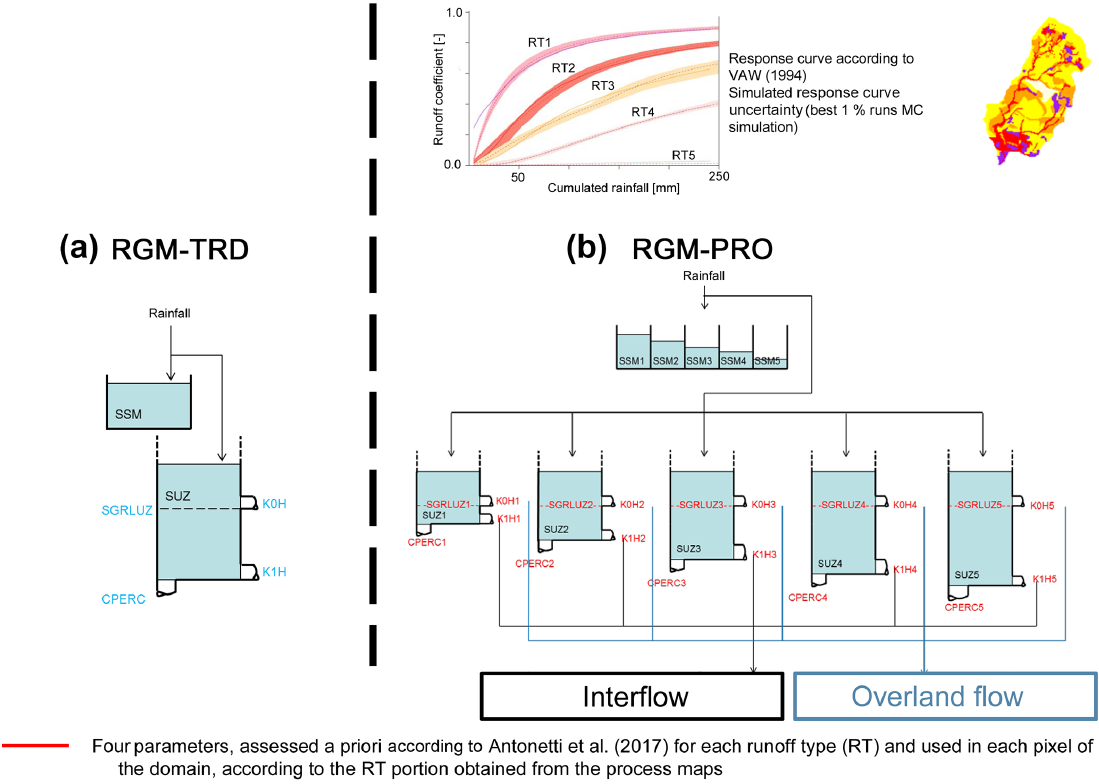
Figure 2. Structure of the adopted RGMs. (a) RGM-TRD module from the traditional PREVAH model, with four parameters requiring calibration (Gurtz et al., 2003) and validity for the whole target area. b RGM-PRO module using typical infiltration curves for a priori estimation of four parameters for five runoff types (Table 2) according to Antonetti et al. (2017) and Antonetti et al. (2016b). RTs are obtained from process maps (Fig.